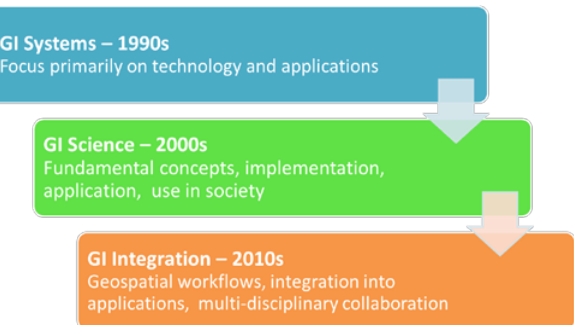
Figure 1: Eras of development in GIScience